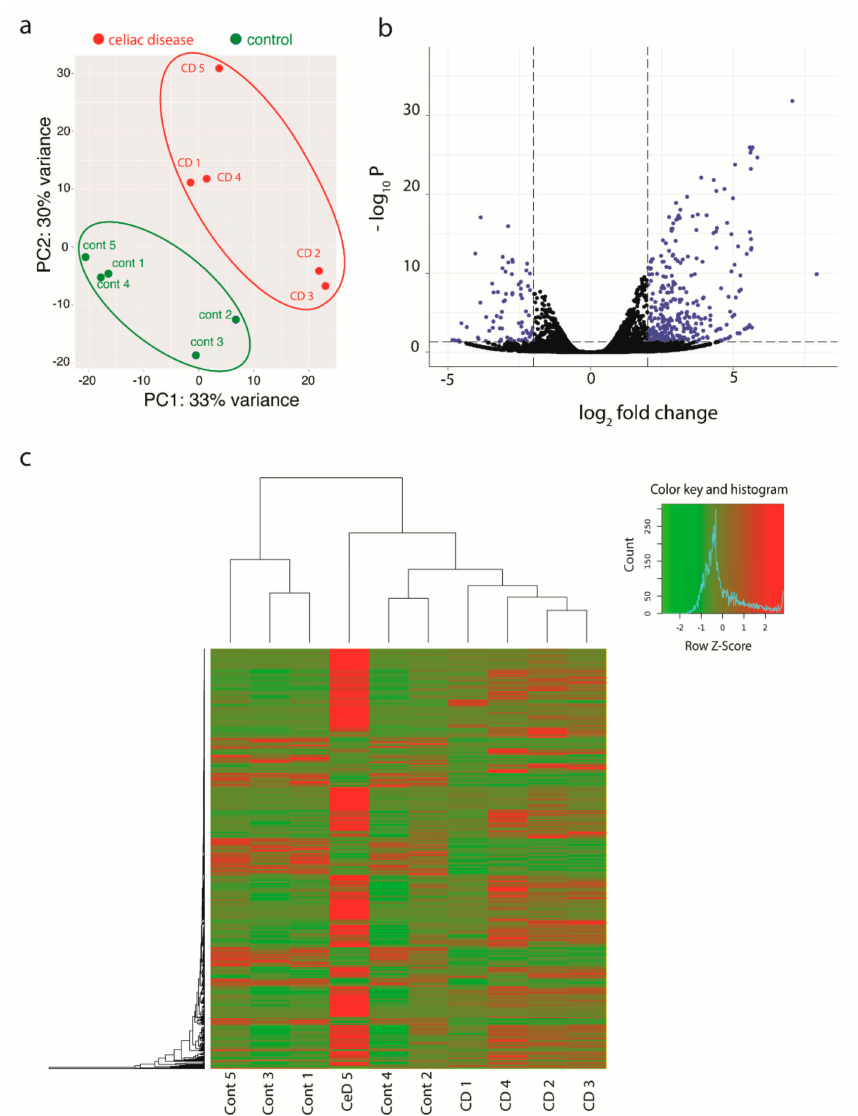
Figure 1. Multivariate visualization of the analyzed genes. ( a ) PCA scatter plot PCA plot showing variance between CD patients’ samples and non-celiac control samples (PC1), and heterogeneity between the five biological replicates in each group (PC2). ( b ) Volcano plot representing the results of the analysis. Each dot representing one gene, and the blue highlighted genes were significantly di ff erentially expressed ( p -value < 0.05) and log fold change cut-o ff 2. ( c ) Heatmap shows hierarchical clustering of genes on the left side and the clustering of the samples on the top. The histogram represents the expression data of the significant di ff erentially expressed genes (green is the down-regulated and red is the